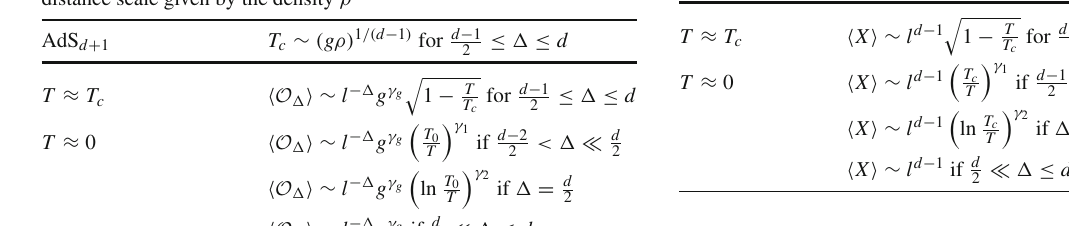
Table 1 T c and (cid:3) O (cid:2) (cid:4) near T = T c and T = 0. Here, γ 1 = (cid:2)( d − 2 (cid:2)) ( γ = (cid:2) and T 0 = ( g ρ) 1 d − 1 respectively, and l = ρ − 1 d − 1 is the 2 2 ( d − 1 ) distance scale given by the density ρ